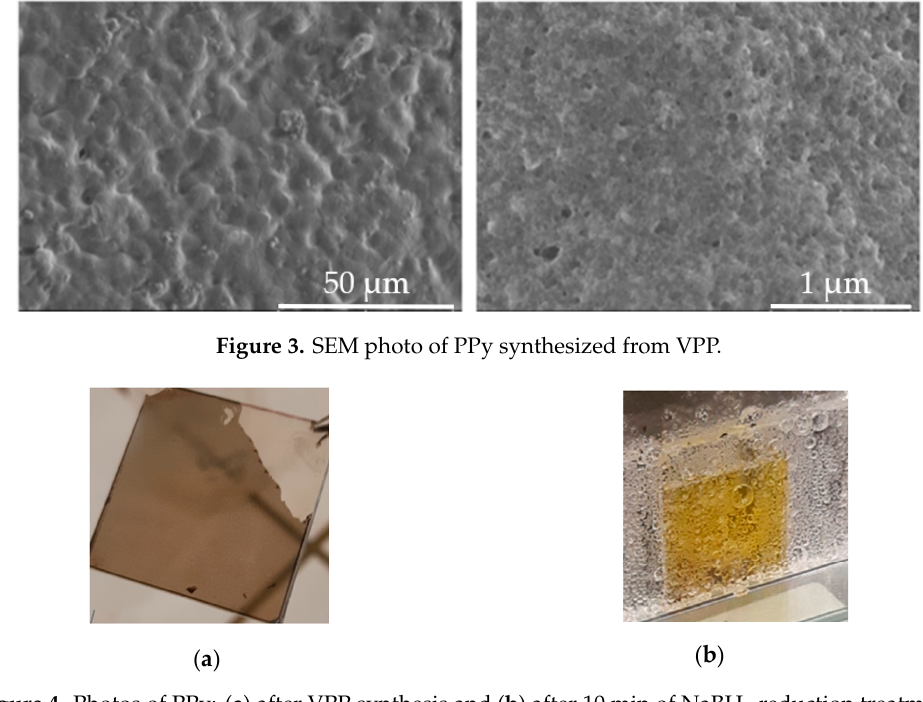
Figure 4. Photos of PPy: ( a ) after VPP synthesis and ( b ) after 10 min of NaBH 4 reduction treatment.